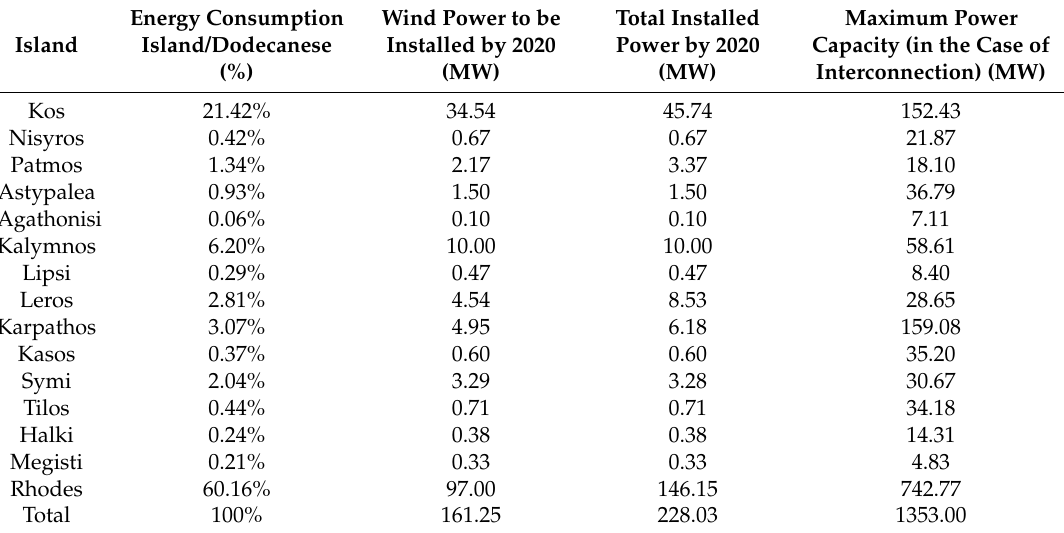
Table 3. Estimated installed capacity for each of the Dodecanese islands in 2020, according to the National Action Plan ”20-20-20”, based on the current status of energy consumption